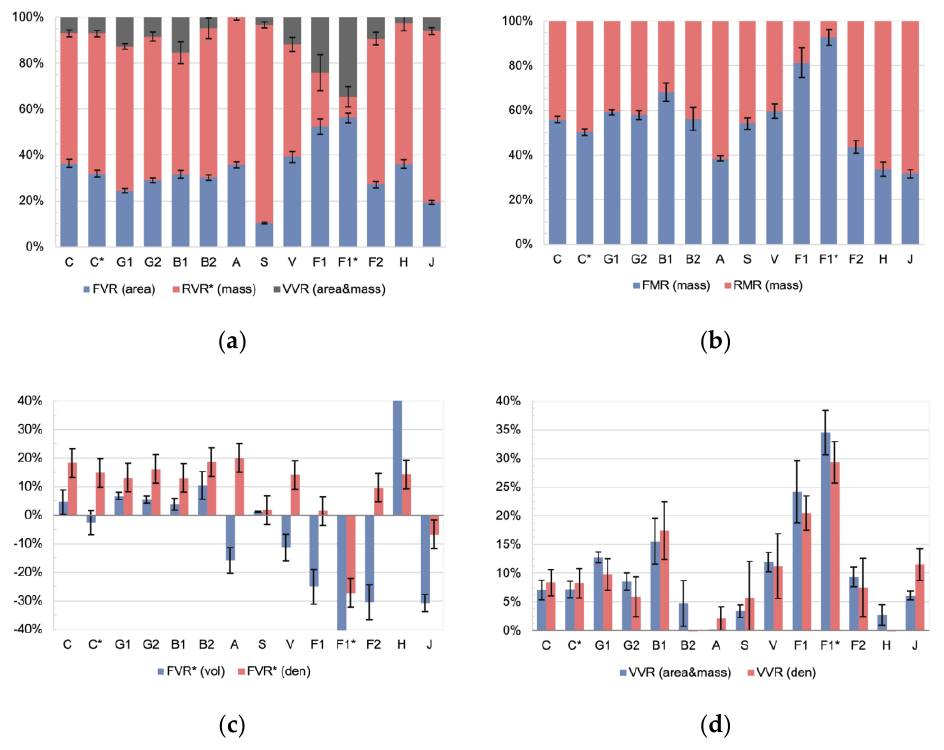
Figure 7. Overview of the inner composite composition of the four-point bending test samples, values marked with an asterisk include a conversion via the density-depended Equations (1) – (4) ( a ) volume ratios; ( b ) mass ratios; ( c ) FVR obtained by volume and density measurements (Equation (8)), with non-plausible values; ( d ) void ratios in comparison.